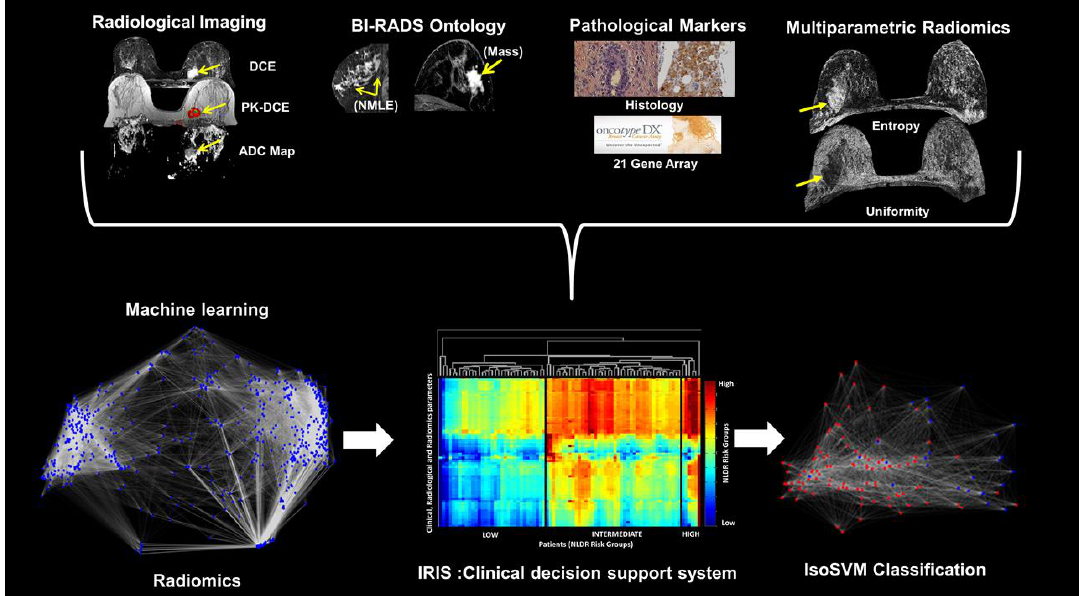
Figure 1. Illustration of the Integrated Radiomics Informatics System (IRIS) using different data inputs and the OncotypeDX. ( Top ) the high dimensional patient space created by the radiological characteristics, informatics, radiomics, and clinical information. ( Bottom ) IRIS transforms the patient space into ( Left ) a complex interaction network for visualization of inter-parameter relationships, ( Middle ) multi-subspace embedding, and clustering heatmap to indicate potential risk identified by each IRIS parameter and the risk signature for each patient, and ( Right ) final patient classes (e.g., low, or high-risk) classified using the combine Isomap and Support Vector Machine (IsoSVM) classification algorithm.